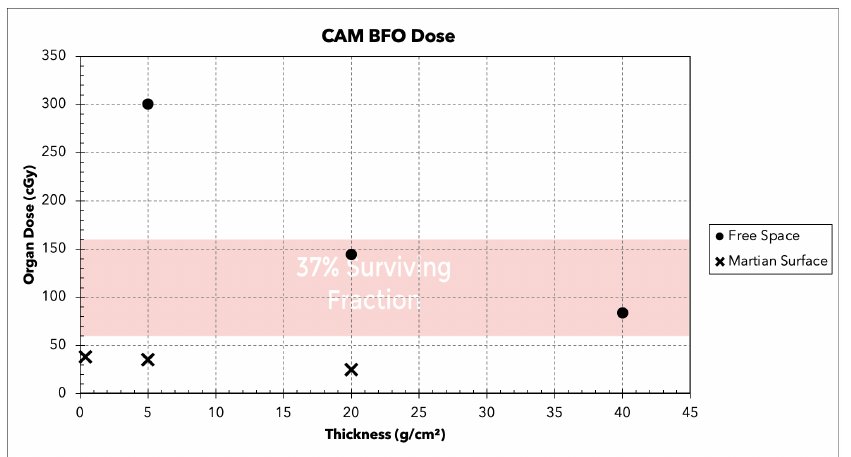
Figure 4. BFO doses from 993/4 SPE for CAM behind various thicknesses of aluminum shielding. The possible biological damage threshold region is labeled in the background.